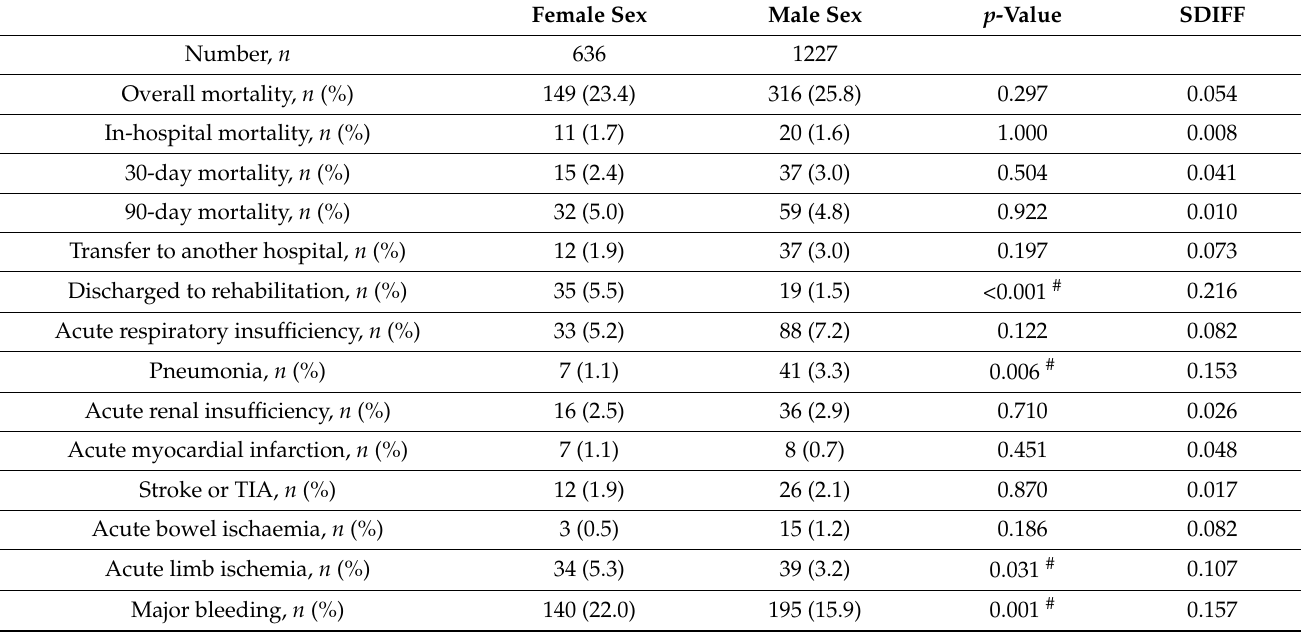
Table 2. Outcomes of the propensity score matched cohort in this retrospective observational study of health insurance claims.